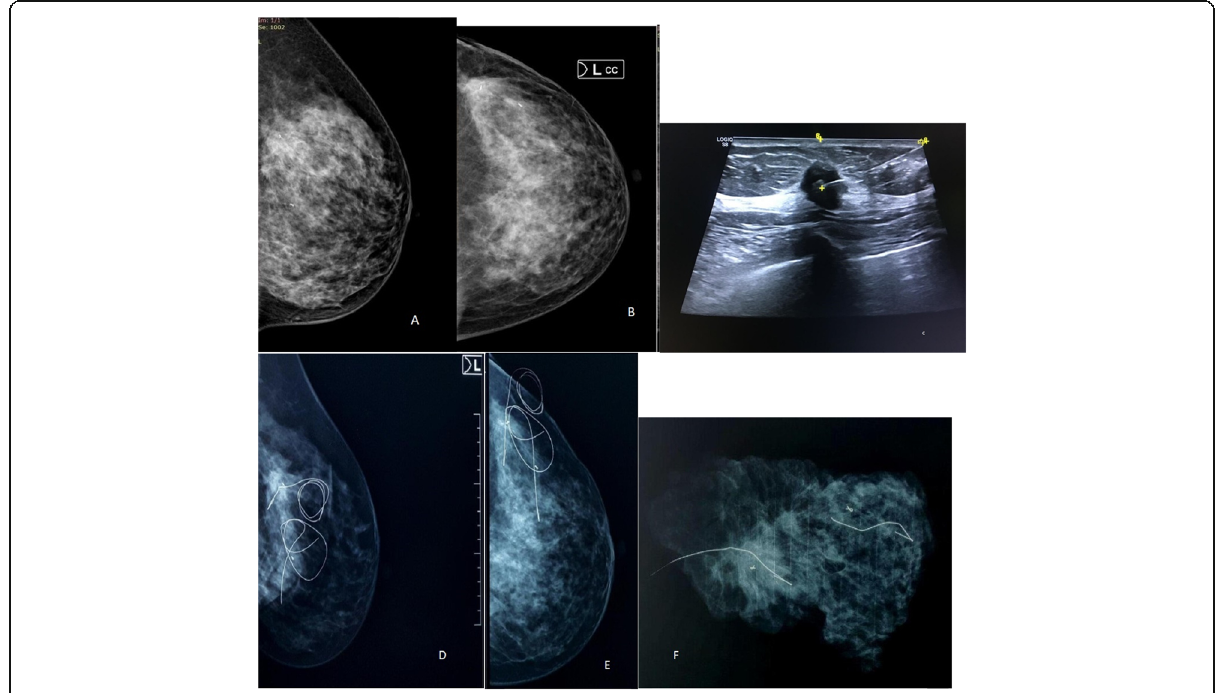
Fig. 6 A 48-year-old female presented with two left breast lump proved to be IDC grade II. Left breast MLO a and CC b view show UIQ suspicious mass with the clip. US-guided clip placement c . Preoperative wire localization MLO d and CC e . Intraoperative specimen mammography f shows clip and wire